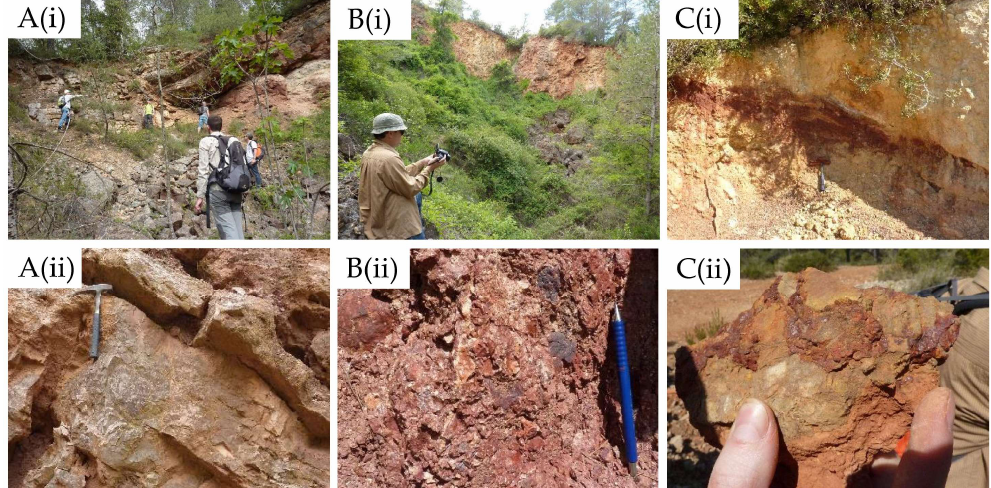
Figure 2. Field photographs of the sampled outcrops ( i ) and close-ups ( ii ) in the CCR: A ( i , ii ) Abandoned mine on the Plana de Casals, B ( i , ii ) abandoned mine El Miracle near Les Pobles, C ( i , ii ) road cutting close to La Pineda de Santa Cristina. Table 1. Coordinates of the sampled sites in the CCR. All positions correspond to WGS84 UTM 31N. Sample Easting